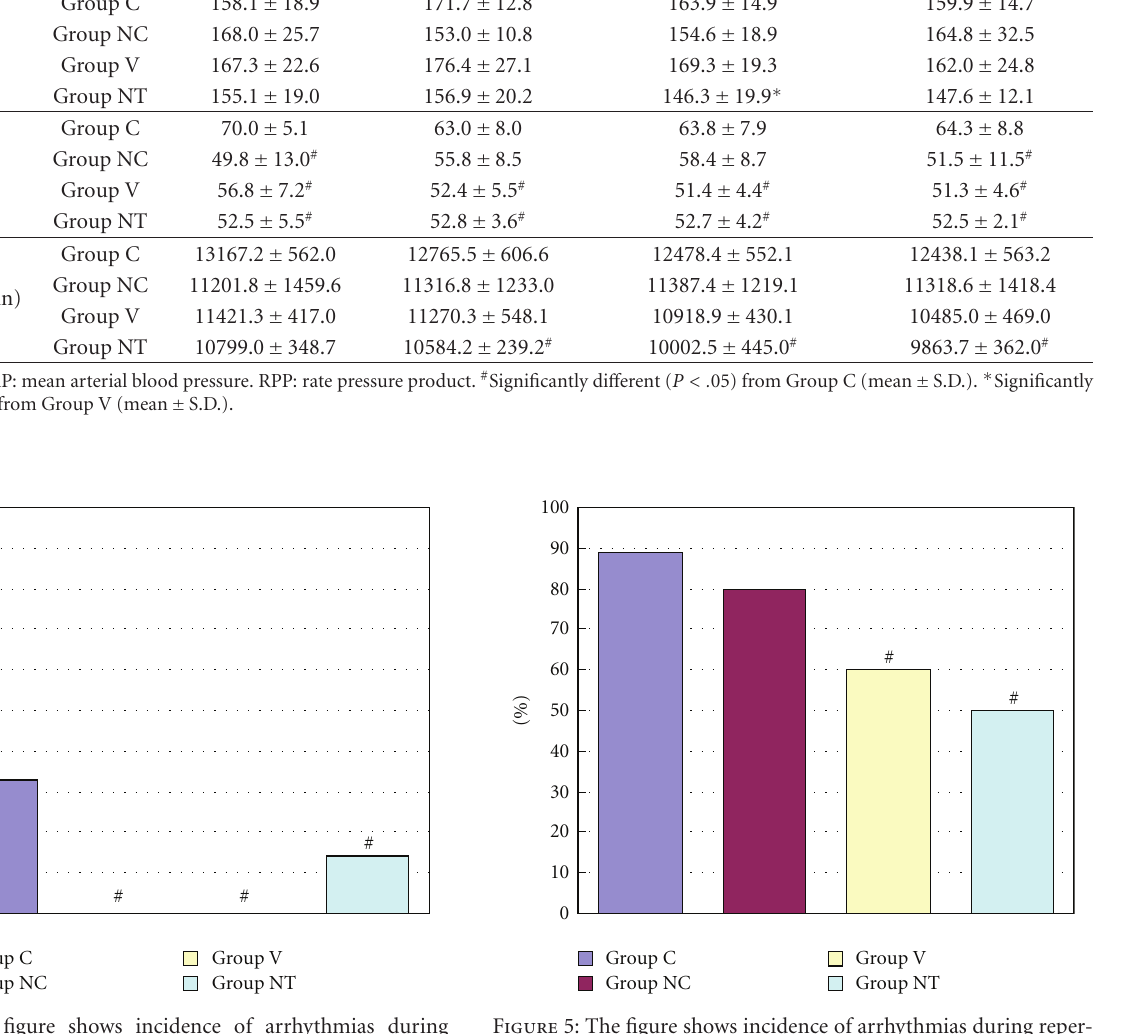
Figure 5: The figure shows incidence of arrhythmias during reper- fusion. Group C: a control group. Group NC: a nicardipine group. Group V: a verapamil group. Group NT: a nitroglycerin group. # Significantly di ff erent ( P < . 05) from Group C (mean ± S.D.).